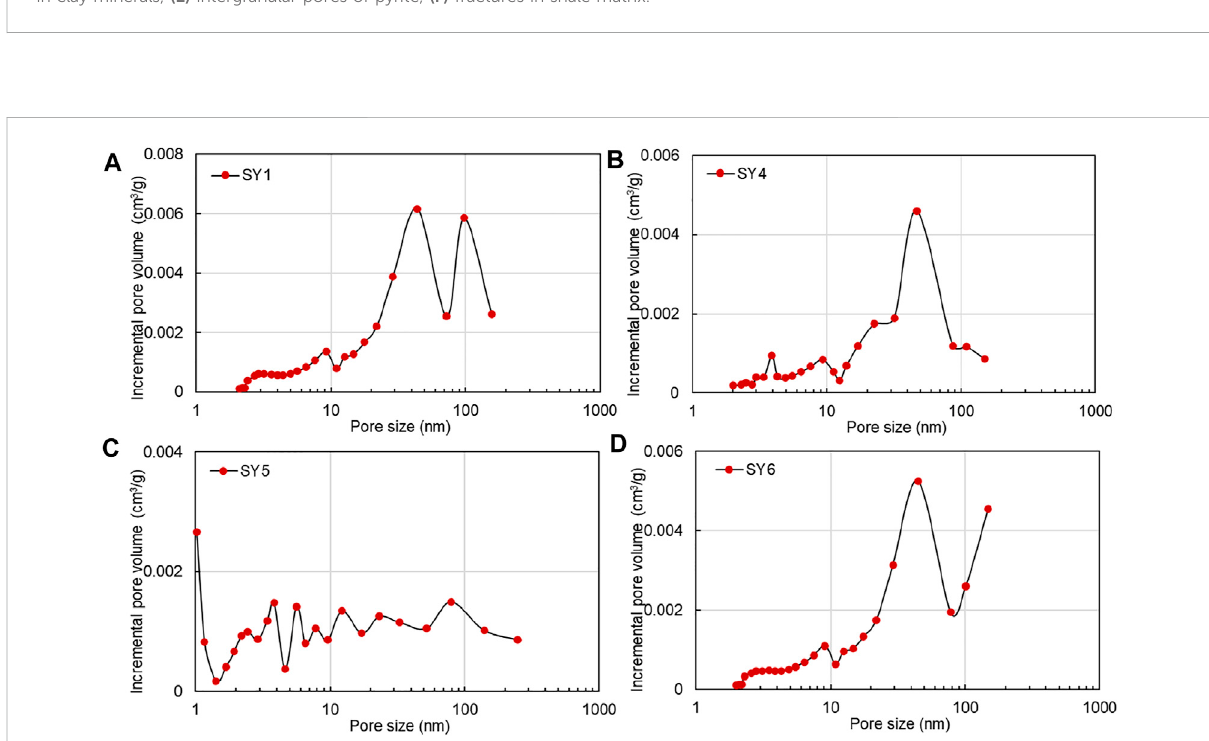
FIGURE 6 Incremental pore volume versus pore size of typical shale